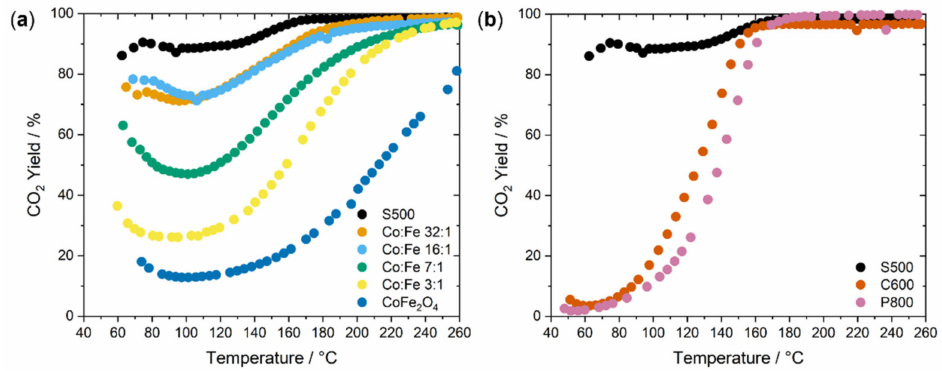
Figure 4. ( a ) Temperature-programmed CO oxidation activation of the SBA-15 templated Fe incorpo- ration series in the 2nd run. ( b ) Temperature-programmed CO oxidation activity of the different Co oxide samples in the 2nd